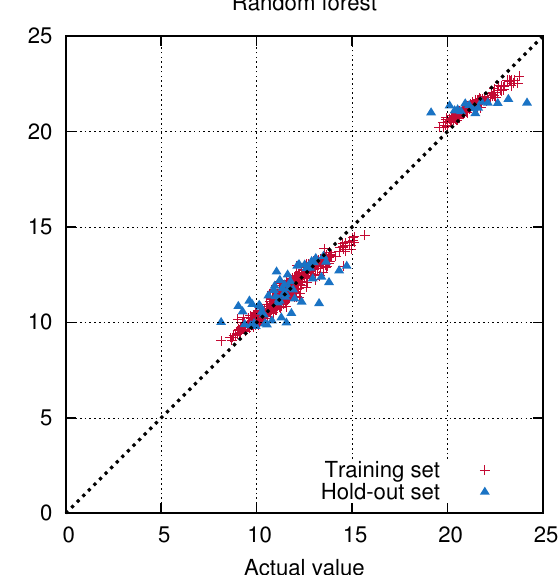
Figure 11. Comparison of the measured and predicted values of R z for the training and hold-out sets, using the best found random forest